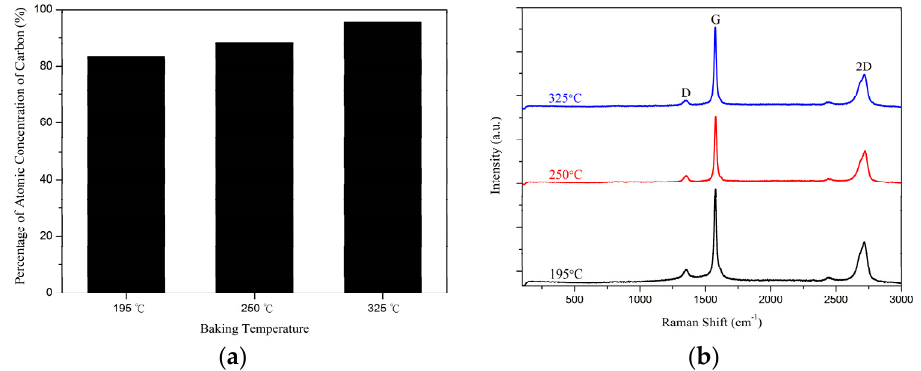
Figure 6. ( a ) X-ray spectroscopy (EDX) analysis and ( b ) Raman spectroscopy were employed to evaluate the quality and layer stacking of graphene baked at different temperatures.